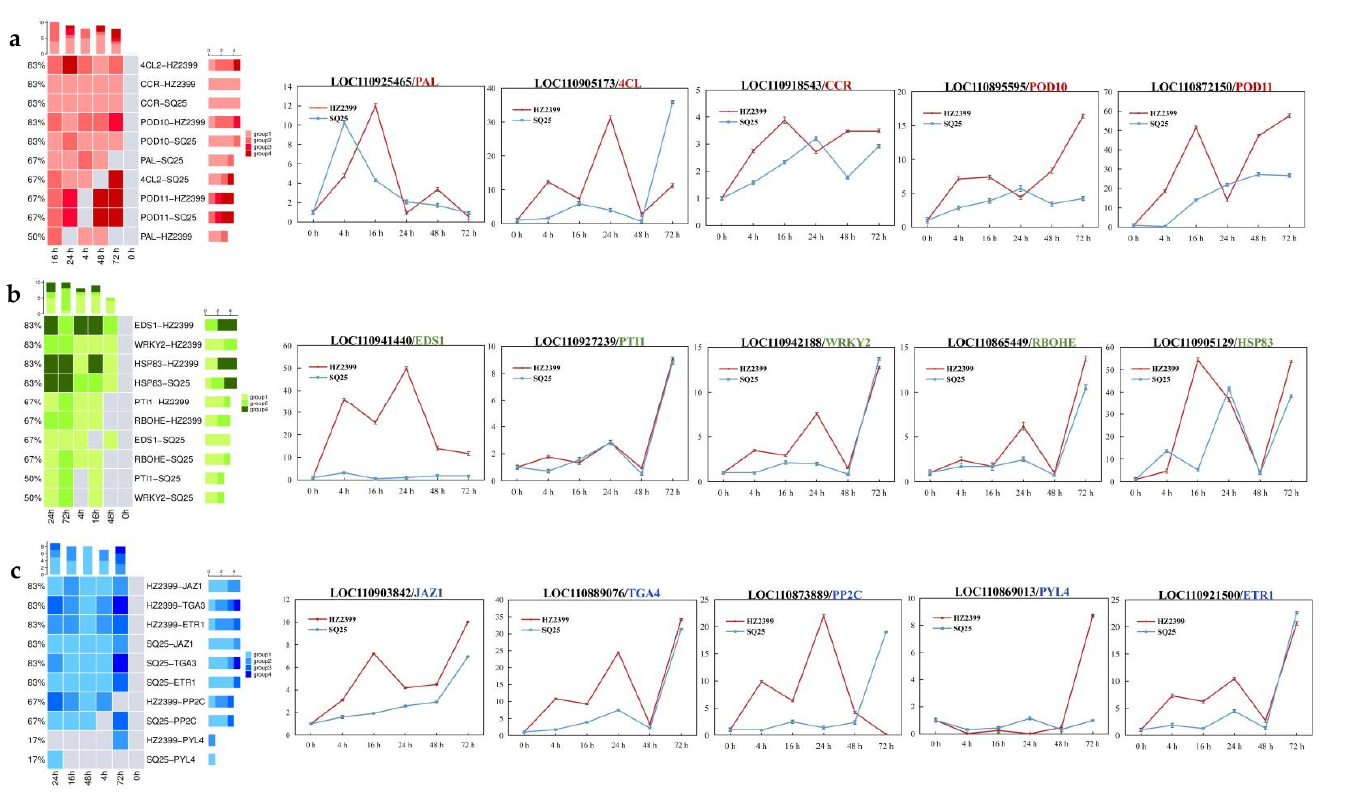
Figure 10. qPCR analysis of 15 important genes. ( a ) Analysis of the expression trend of the key genes in the phenylpropanoid biosynthesis pathway ( PAL , 4CL2 , CCR , POD10 , and POD11 ) in HZ2399 and SQ25 and binary heatmap. ( b ) Analysis of the expression trend of the key genes in the plant– pathogen interaction pathway ( EDSI , PTI1 , WRKY2 , RBOHE , and HSP83 ) in HZ2399 and SQ25 and binary heatmap. ( c ) Analysis of the expression trend of the key genes in the plant hormone signal transduction pathway ( JAZ , TGA3 , PP2C , PYL4 , and ETR1 ) in HZ2399 and SQ25 and binary heatmap. Group1: 1 < n ≤ 5; Group2: 5 < n ≤ 15; Group3: 15 < n ≤ 25; Group4: n > 25.